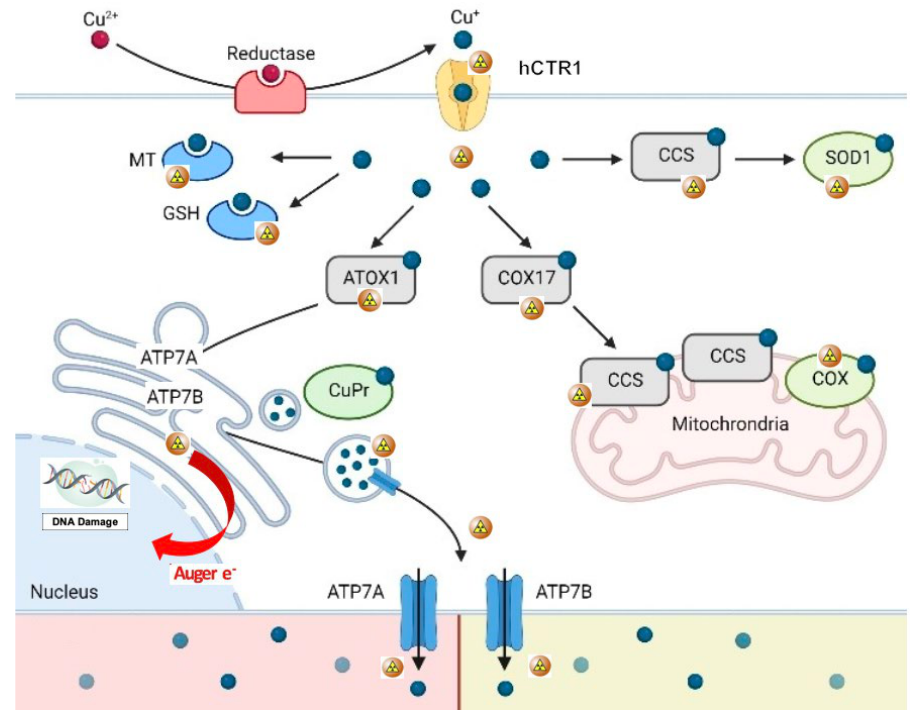
Figure 1. Schematic representation of copper metabolism at the cellular and molecular level ( 64 Cu as copper ions). 64 Cu 2+ ions are bound to plasma proteins which carry them to the external membrane, where they are reduced to Cu 2+ by reductases before their uptake into cells. Reduced copper ions are then transported across the cell membrane by the human copper transporter 1 (hCTR1). In the cell, Cu 2+ ions are closely bound by copper chaperones (cytochrome c oxidase copper chaperone (COX17), copper chaperone for SOD1 (CCS), and antioxidant protein (ATOX1)), which deliver copper ions to the cytosol (via SOD1), mitochondria (via COX) and trans-Golgi network (via copper transporting ATPase A/B). Interestingly, glutathione (GSH) binds excess Cu 2+ to prevent oxidative damage, thus protecting the cell from copper toxicity. Analogous mechanisms are carried out by metallothionein (MT). When intracellular copper is too high, hCTR1 is internalized and destroyed and copper transporting ATPase A/B (ATP7A and ATP7B) transfer from the TGN to the plasma membrane to help in the excretion of copper from the cell (adapted and modified from Michniewicz F. et al.: Copper: An Intracellular Achilles’ Heel Allowing the Targeting of Epigenetics, Kinase Pathways, and Cell Metabolism in Cancer Therapeutics. Chem Med Chem 2021 , 16 , 2315–2329. Copyright Wiley-VCH GmbH. Reproduced with permission.).